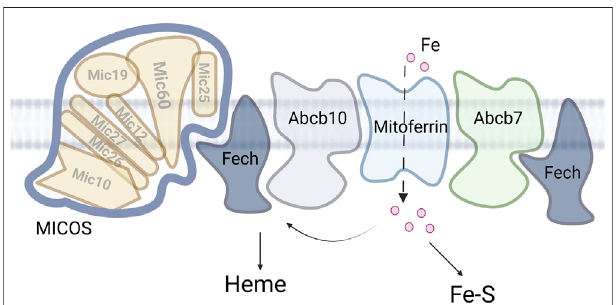
FIGURE3 | MICOSand mitochondrial iron. Iron enters themitochondria via the MCF mitoferrin. The iron is then partitioned between heme synthesis, Fe-S assembly and other iron. Accumulation of the other iron is deleterious in multiple disease